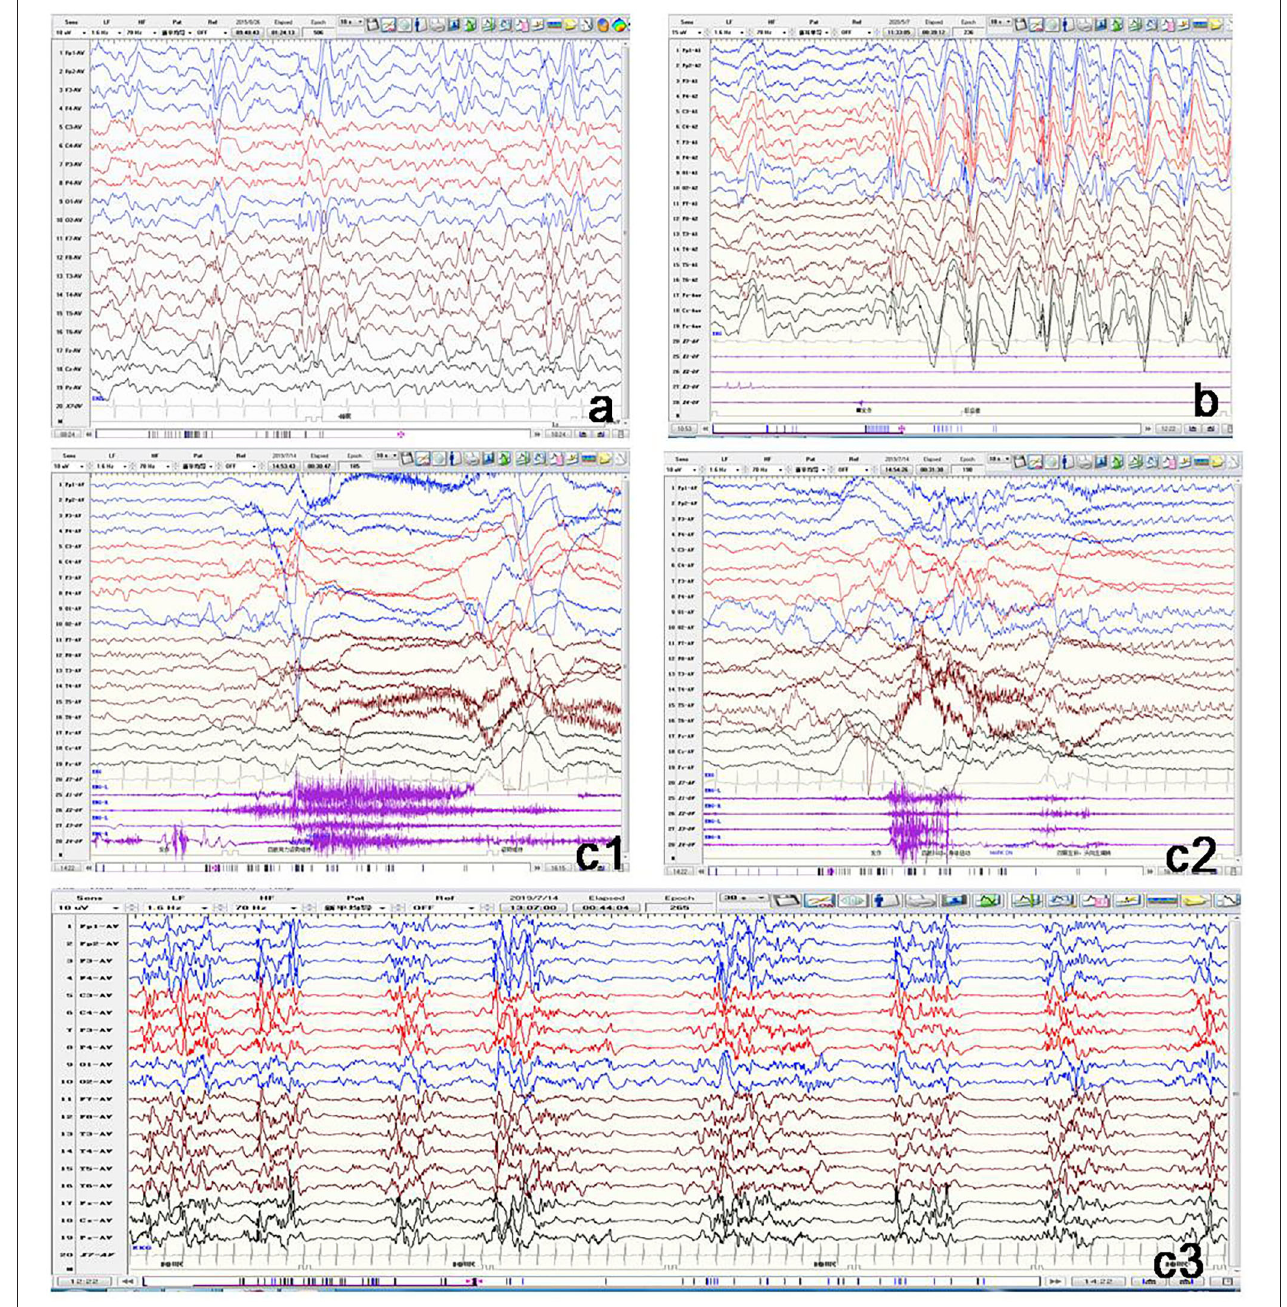
FIGURE 3 | Representative electroencephalogram (EEG) of three patients with GNAO1 variants. (a) Patient 1: Interictal EEG showing hypsarrhythmia. (b) Patient 2: Ictal EEG of atypical absence seizures monitored by generalized high-amplitude 1.5Hz spike slow wave for several seconds. (c) Patient 5: c1: Ictal EEG of tonic spasm seizures showing widespread high-amplitude sharp wave, slow wave, and fast wave with a broad voltage reduction lasting several seconds. c2: Ictal EEG of focal seizures initiated from left occipital and posterior temporal regions. c3: Interictal EEG demonstrating suppression-burst pattern.